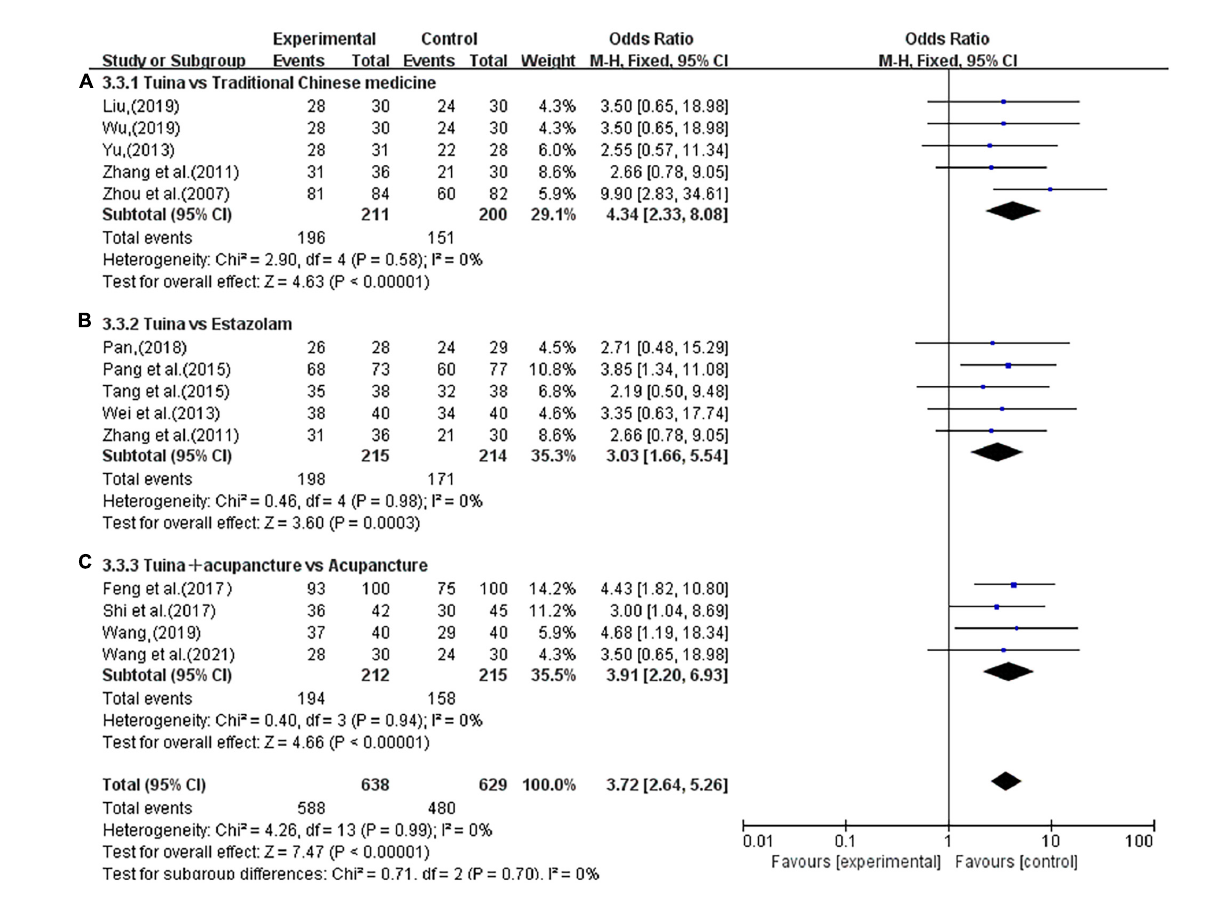
FIGURE6 Subgroup analysis of tuina and different interventions in ORR. (A) Traditional Chinese Medicine (TCM). (B) Estazolam. (C) Acupuncture.